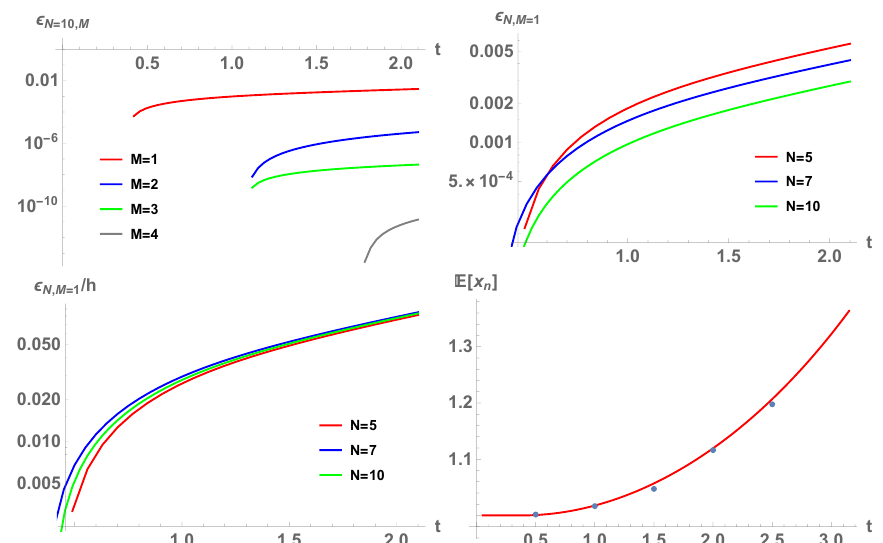
Figure 3. Upper left panel: Absolute errors (log-scale) in the approximation of the mean value with the NSFD scheme, with M = 1,2,3,4 and N = 10 ( h = τ / N ). Upper right panel: Absolute errors (log-scale) in the approximation of the mean value with the NSFD scheme, with N = 5,7,10 ( h = τ / N ) and M = 1. Lower left panel: Errors from the upper right panel divided by h . Lower right panel: Approximation of the expectation with the NSFD scheme, with M = 1 and N = 7, and comparison with Monte Carlo simulation (circles) using 10,000 realizations. This figure corresponds to Example 2.